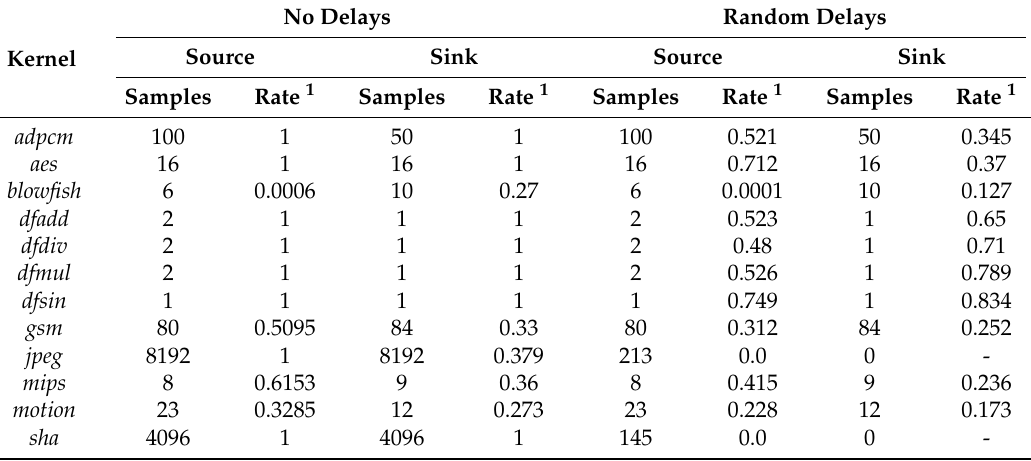
Table 2. Rates from CHStone